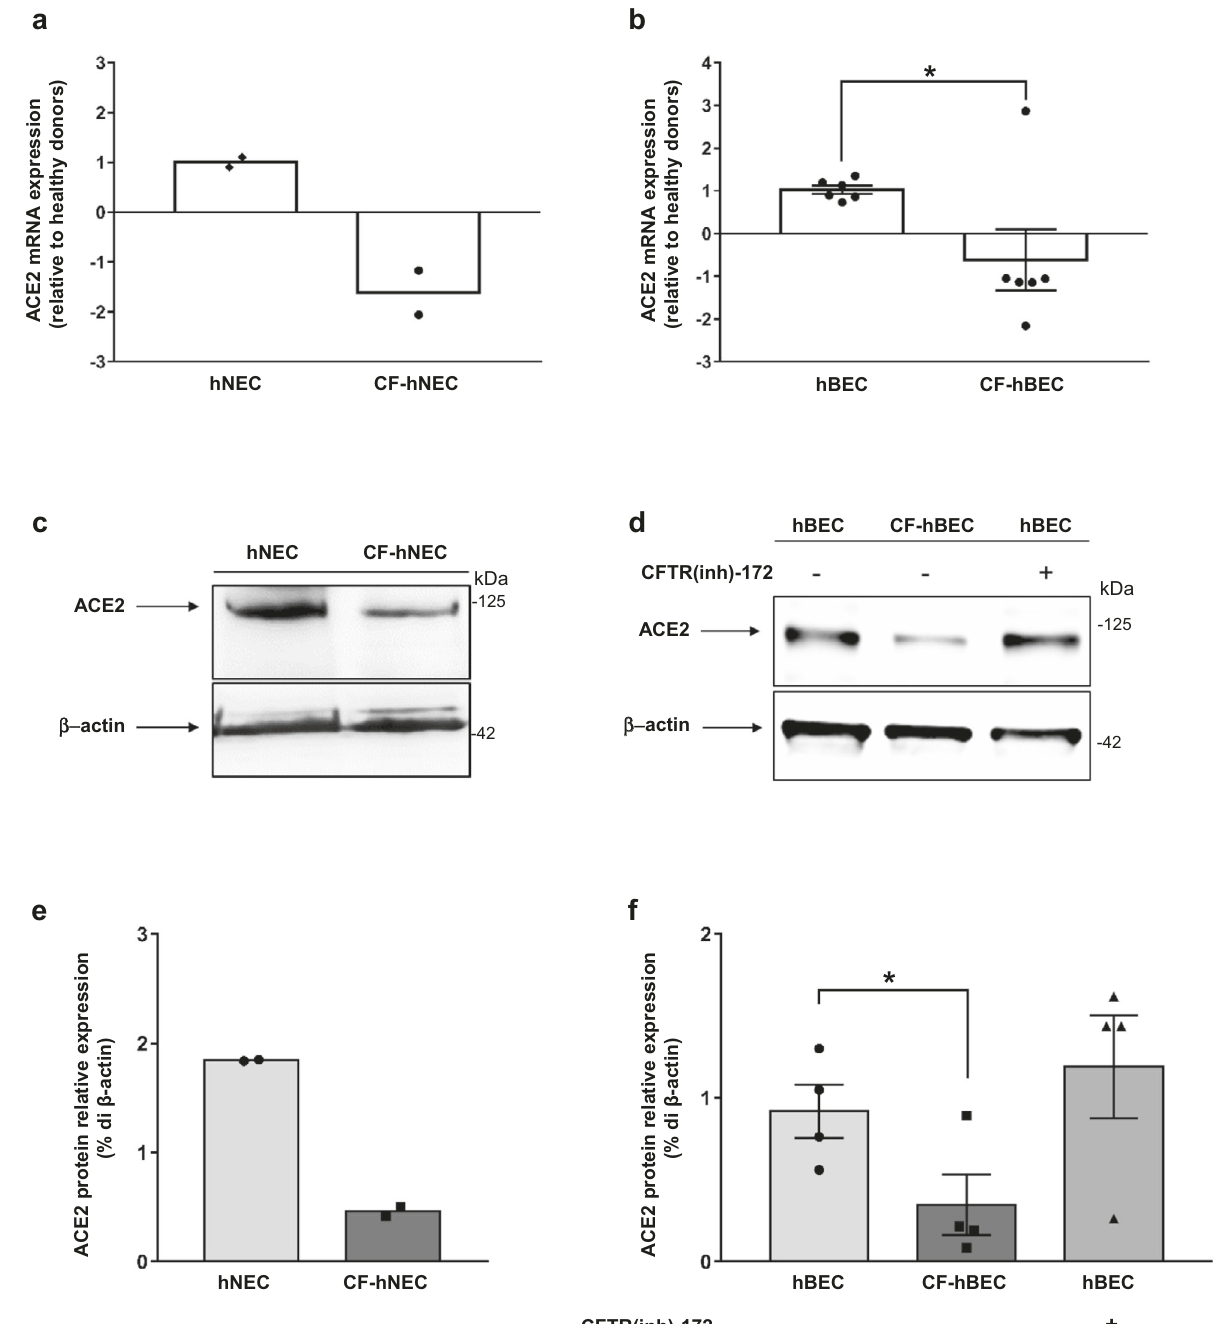
Fig. 1 | ACE2 expression is reduced in CF airway epithelia. a , b Quanti fi cation of ACE2 mRNA expression by qPCR in lysates collected from well-differentiated hNECs and hBECs, grown at the air-liquid interface. Epithelia were derived from a pooloffourteenhealthydonors(hNEC)andtwoCFpatients(CF-hNEC)( a ),orfrom six healthy donors (hBEC) and six CF patients (CF-hBEC) ( b ). The genotypes of the patients enrolled in this study are reported in Supplementary Table 1. Data are shown as the mean±SEM of independent experiments ( n =4 and n =6 for hNEC and hBEC, respectively). c Representative western blot analysis of protein extracts fromdifferentiatedhNECsgrownattheair – liquidinterfaceobtainedfromapoolof fourteen healthy control subjects versus CF-hNECs obtained from two F508del- CFTR homozygous CF patients. d Western blot analysis of ACE2 in differentiated